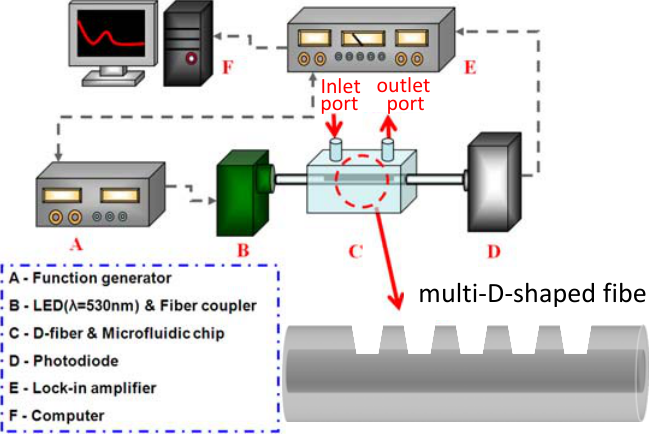
Figure 8. Schematic of the experimental setup for refractive index measurements with the multi-D-shaped optical fiber. The inlet and outlet ports of the microfluidic chip are used to infuse sucrose solution flowing through the sensing fiber.